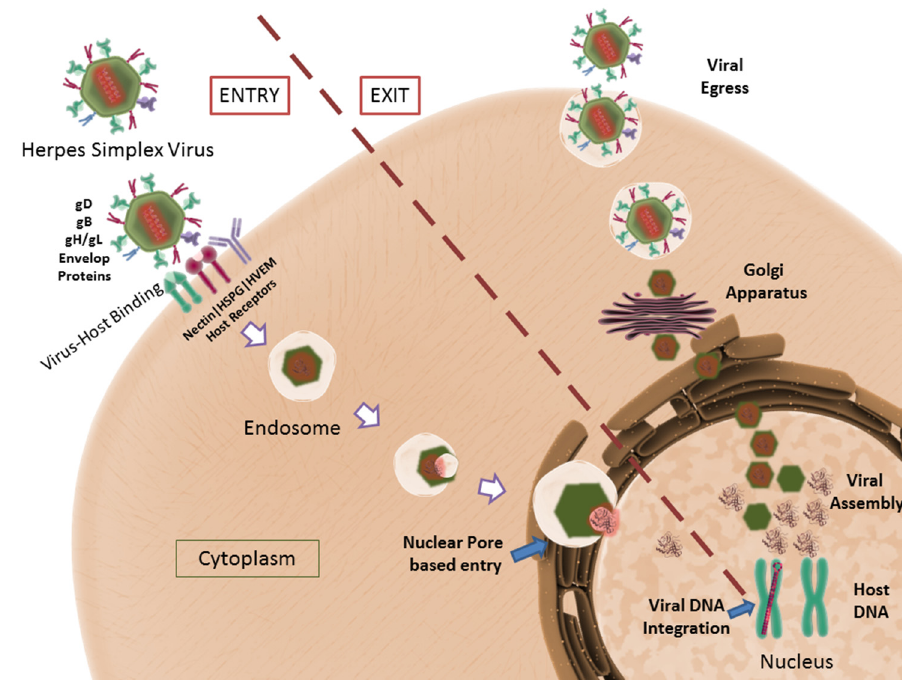
Figure 8. HSV life cycle depicted: The viral proteins gD, gB, gH/gL facilitate virus–host binding. The host receptors, Nectin, HVEM and HSPG have been shown to assist viral entry. The transcription and translation of viral genes are followed by viral egress. CC BY 4.0 license